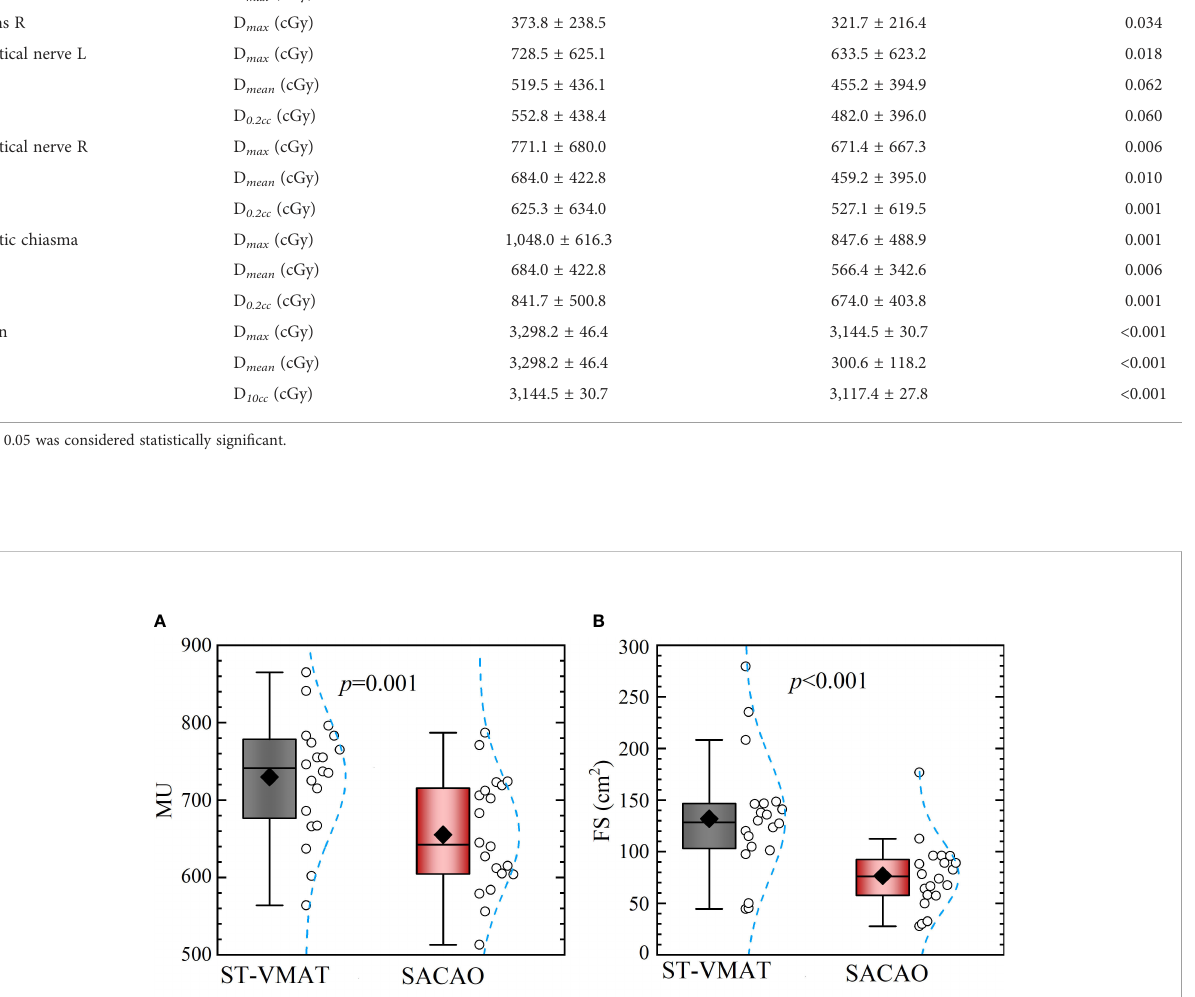
FIGURE 5 Statistical comparison of MUs (A) and fi eld sizes (B) between ST-VMAT and SACAO plans for all patients. For SACAO plans, the fi eld sizes are weighted average of sub-arcs for each patient.